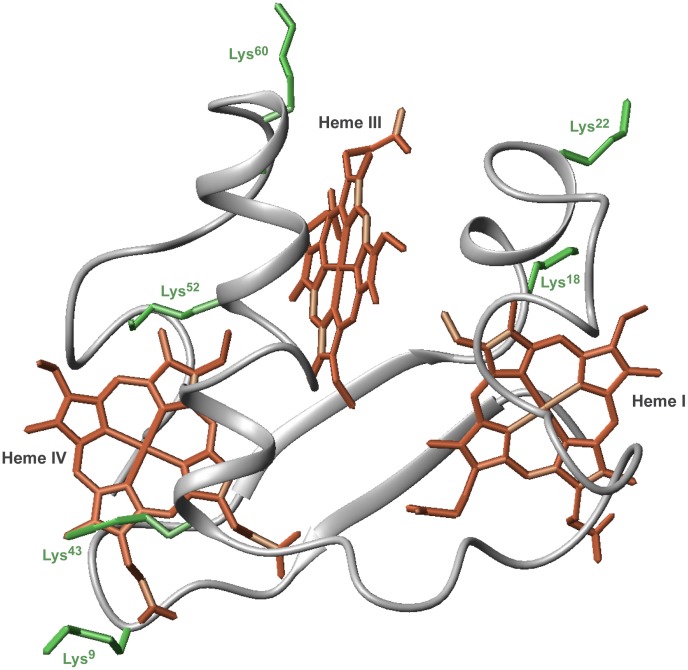
Spatial location of lysine residues mutated in this work depicted in PpcA solution structure (PDB code, 2LDO [11]).The PpcA polypeptide chain (gray) is shown as Cα ribbon and heme groups (red). The side chain of Lys9, Lys18, Lys22 Lys43, Lys52 and Lys60 (green) are represented as stick drawings. The hemes are numbered I, III and IV, a designation that derives from the superimposition of the hemes in cytochromes c
7 with those of the structurally homologous tetraheme cytochromes c
3.